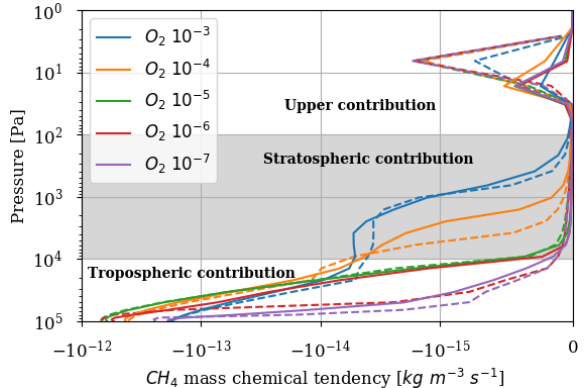
Figure 5. Methane photochemical losses as a function of altitude for several O 2 levels and a methane VMR of 10 − 4 at the surface. Solid: results of the 3D model (averaged over the surface and a year). Dashed: 1D